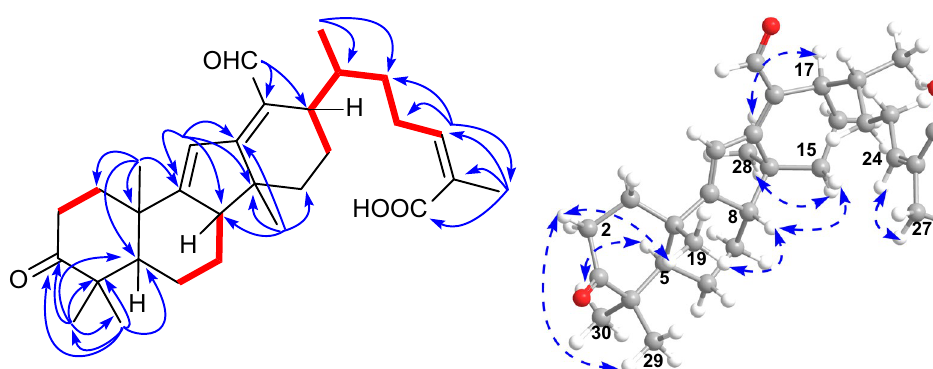
Fig. 2 Key 1 H– 1 H COSY (red and bold), HMBC (blue arrows), and ROESY (dashed arrows) correlations of 1